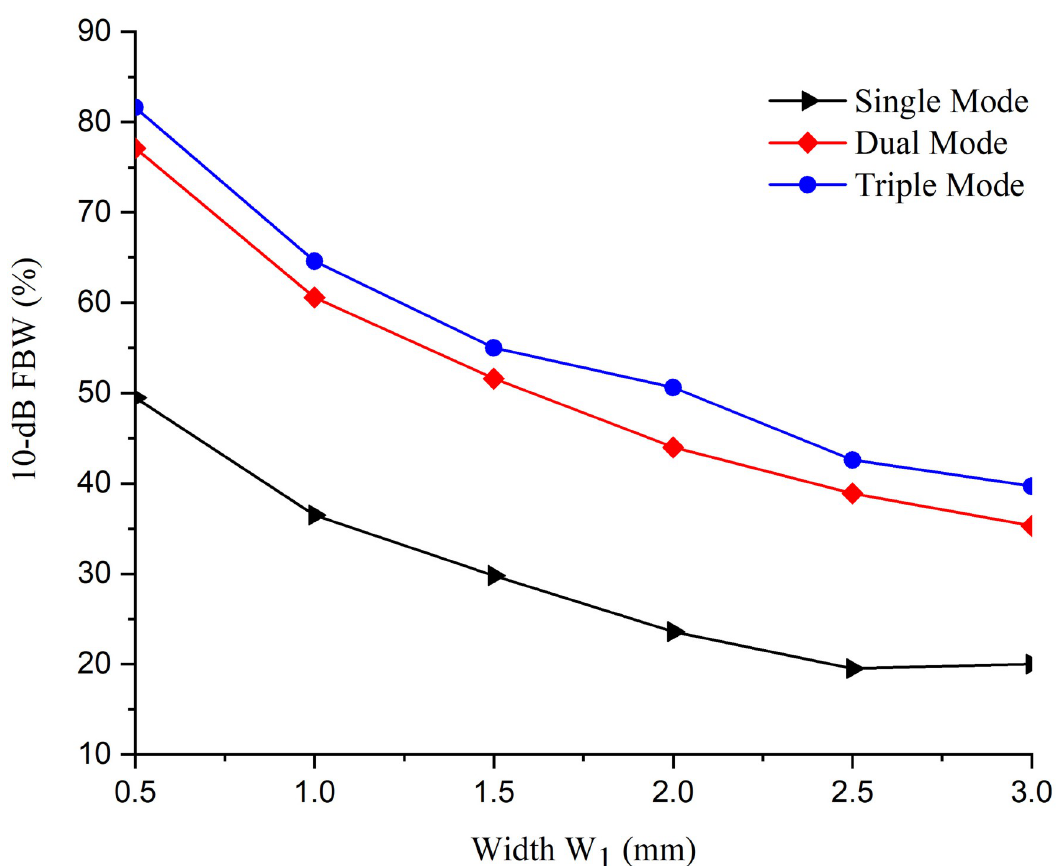
Fig 7. 10 dB Fractional bandwidth response with variable width W 1